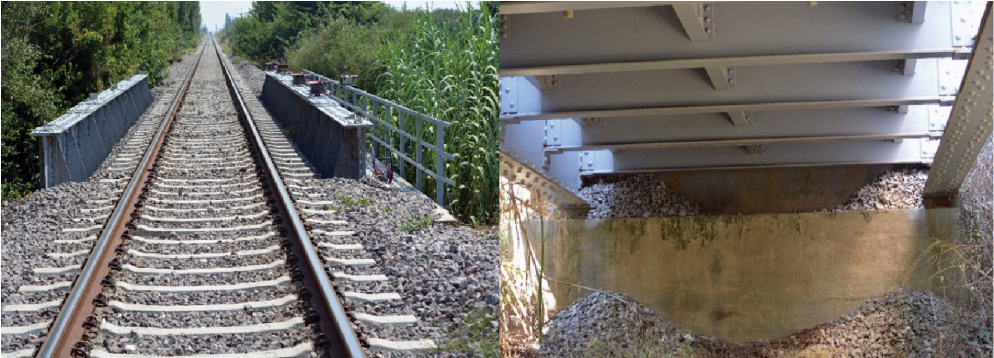
Figure 2. General view of the bridge